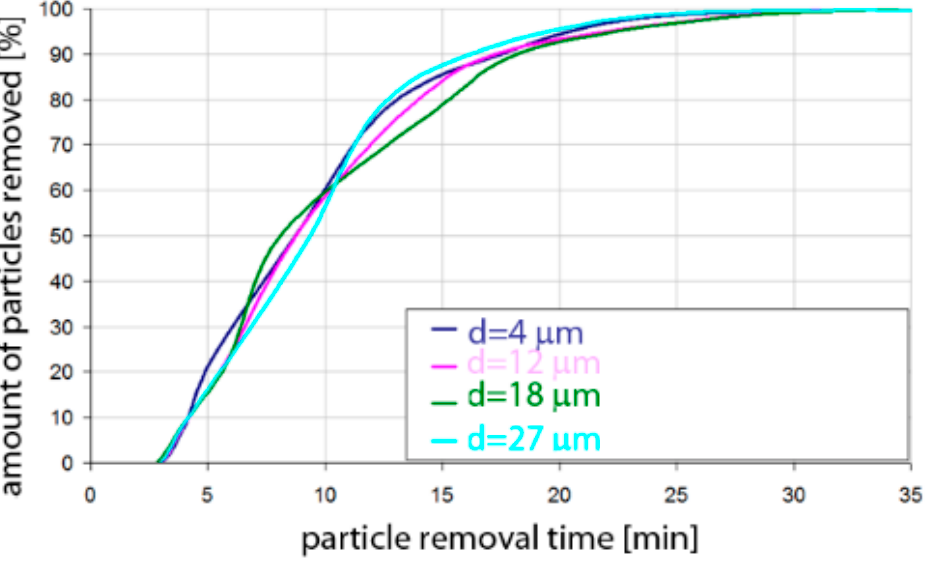
Figure 17. Share of removed non-metallic Al 2 O 3 inclusions from the analysed ladle in the case of argon flow of 50 L/min through the 18CrNiMo7-6 steel.